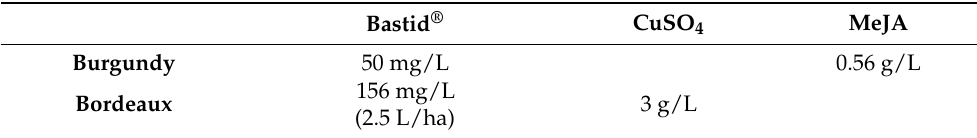
Figure 8. Experimental design. Experiments were conducted in Burgundy (cv. Chardonnay) and Bordeaux (cv. Cabernet Franc) vineyards at three phenological stages of grapevines in 2017, 2018 and 2019. Vines were treated with water (control) or an elicitor twice at seven days interval before the start of the experiment (D0). VOCs were collected on SBSE sensors at 3 time points (D3, D5 and D7). The leaves used for phenolics analyses were picked on D2 and D7. *: not in 2019. The elicitor doses were adjusted and are indicated in Table 6. Bastid ® was purchased from Syngenta (Saint-Sauveur, France) and used as described by [13]. MeJA was purchased from Sigma Aldrich (Lyon, France). CuSO 4 was amended as Bordeaux mixture (RSR), containing 20% active copper. Water was used as a control treatment for comparisons. Table 6. Products and doses used for the treatments in the Burgundy and Bordeaux vineyards. Dilution in water: Bastid ® , CuSO 4 (Bordeaux mixture) and MeJA (2.5 mM). The difference in Bastid ® concentrations between Burgundy and Bordeaux is due to the calibration specifications of the sprayers: a hand sprayer (600 L · ha − 1 ) in Burgundy; an SR 420 atomizer (Stihl ® , Torcy, France, 200 L · ha − 1 ) in the Bordeaux vineyard.